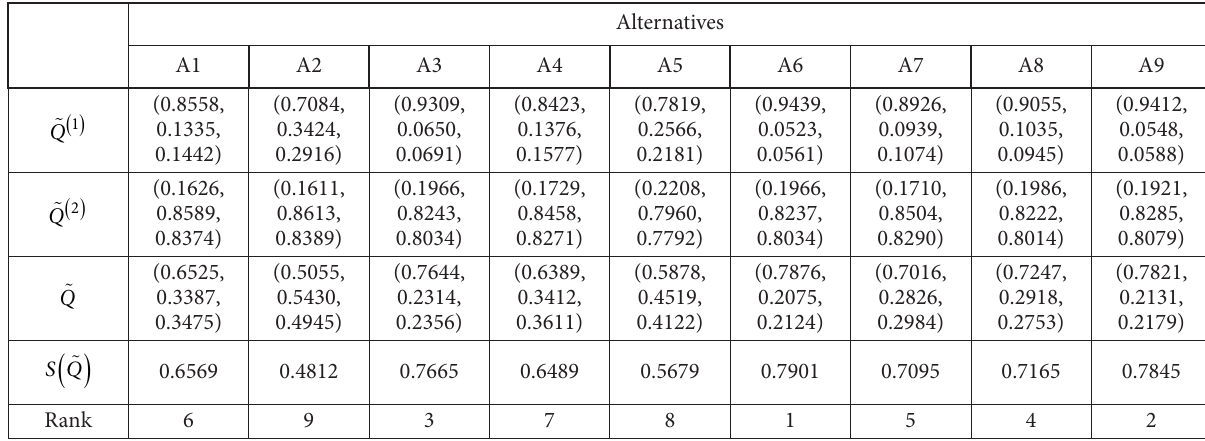
Table 8. Numerical results of WASPAS-SVNS